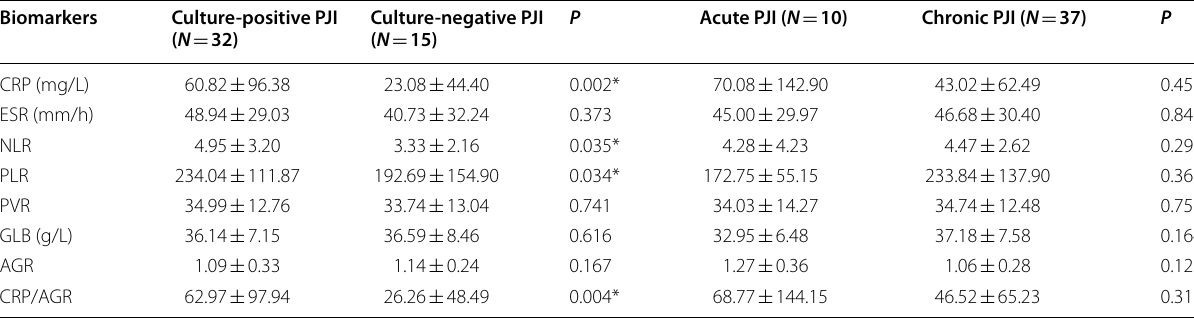
Values are given as mean SD ± CRP C-reactive protein, ESR erythrocyte sedimentation rate, NLR neutrophil-to-lymphocyte ratio, PLR platelet-to-lymphocyte ratio, PVR platelet-to-mean-platelet- volume ratio, GLB globulin, AGR albumin-to-globulin ratio * P <